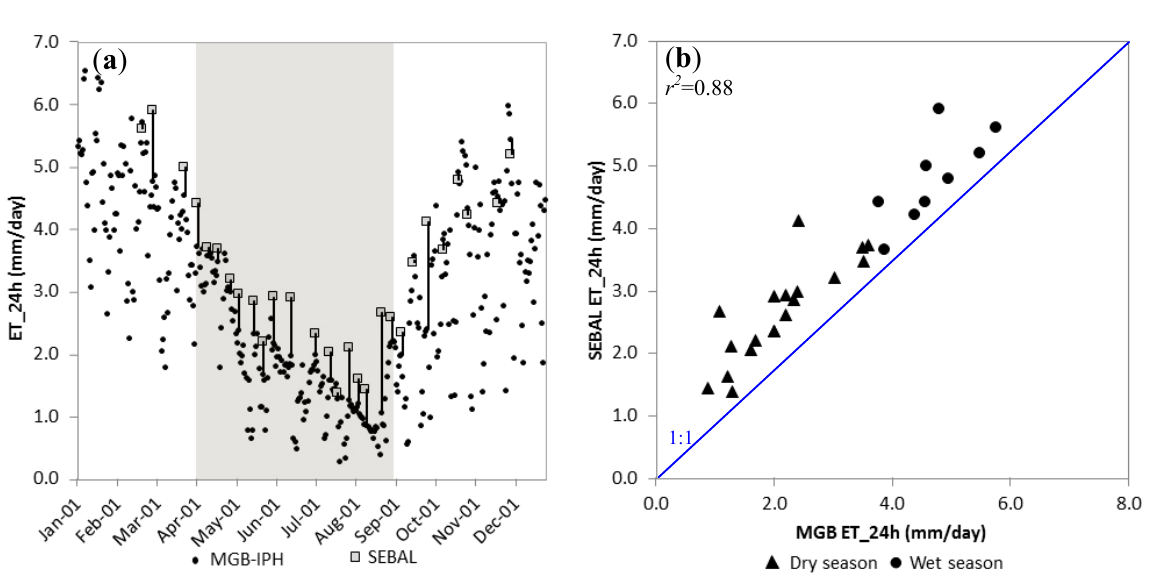
Figure 8. Seasonal variation ( a ) and correlation ( b ) between daily evapotranspiration estimated using SEBAL algorithm and hydrological model MGB-IPH for an overlay of 38,100 km 2 . Bars in (a) are the differences between estimates given by the two models. The climatological dry season is